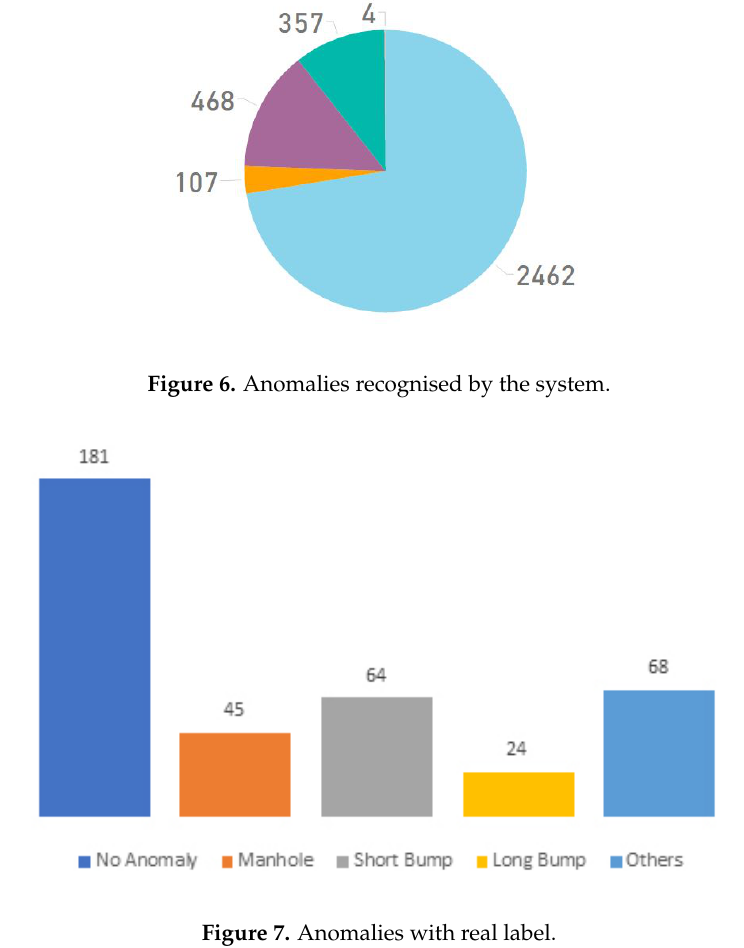
Figure 7. Anomalies with real label.